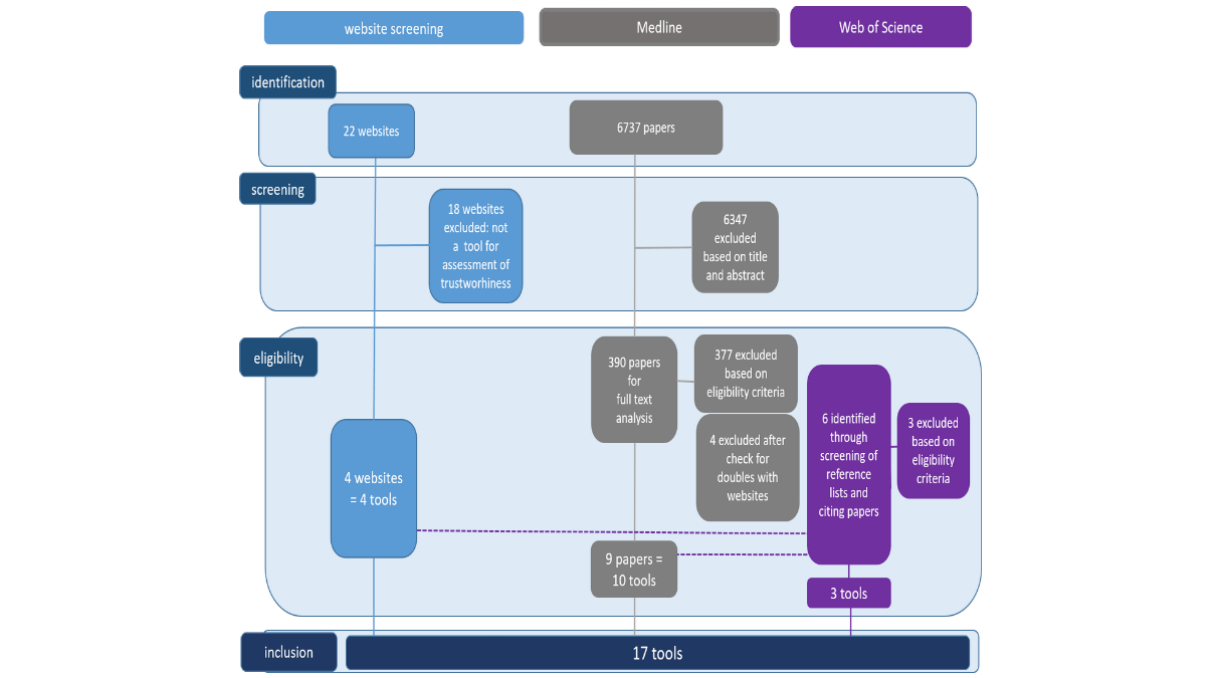
Figure 1. Search